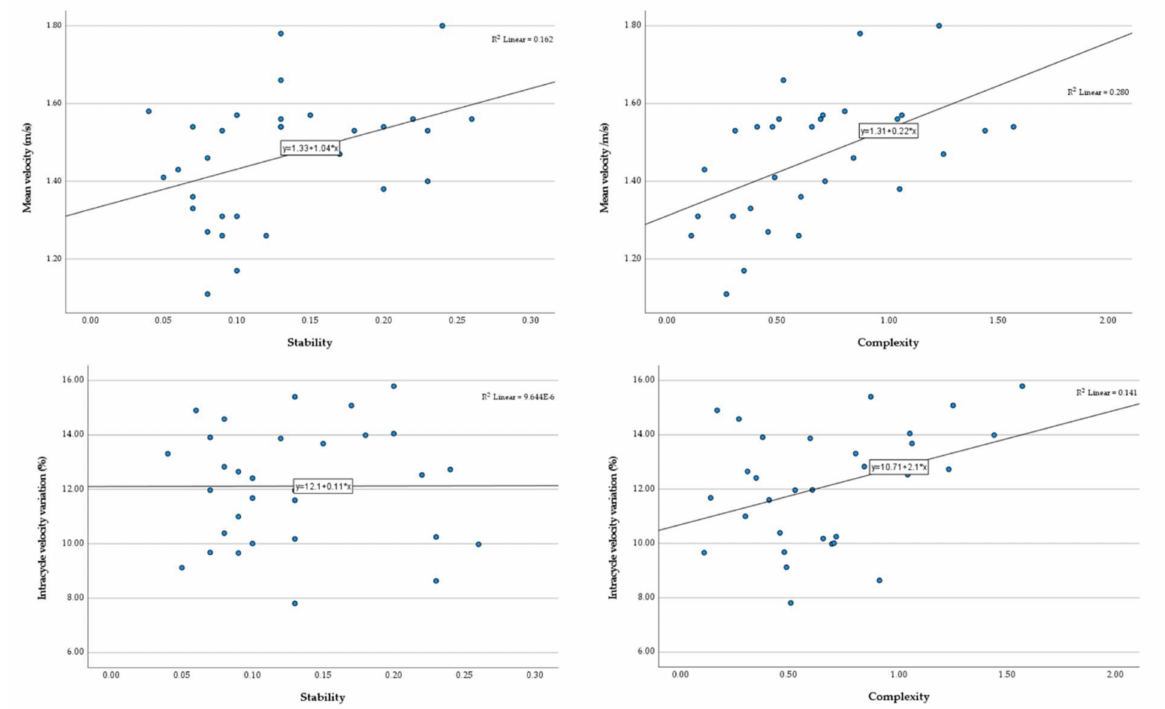
Figure 5. Relationship between mean velocity and stability, mean velocity and complexity, intracycle velocity variation and stability, and intracycle velocity variation and complexity (upper left and right, and lower left and right panels,